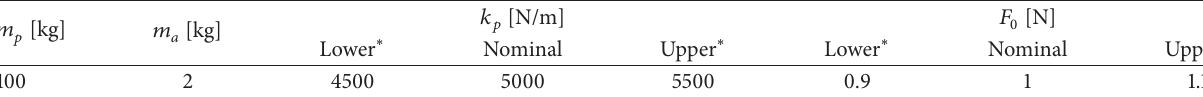
Table 1: Parameters used for the design of the linear DVA.